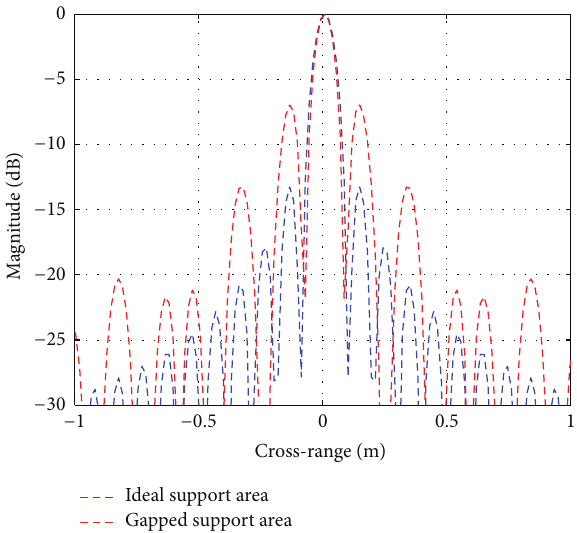
Figure 5: The PSF figures in the cross-range direction. In the figure, the blue lines denote the PSF for the ideal support area, that is, Figure 4(a). The red lines denote the PSF for the gapped support area, that is, Figure 4(c).